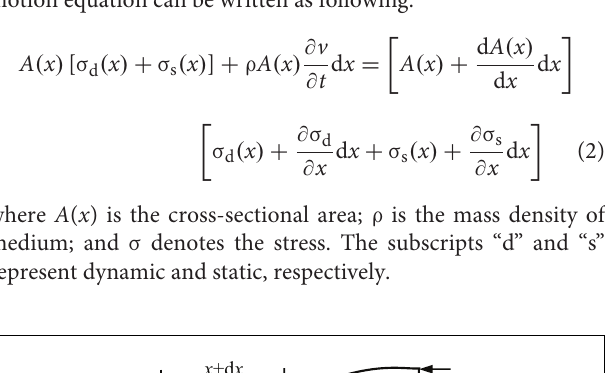
Frontiers in Earth Science |